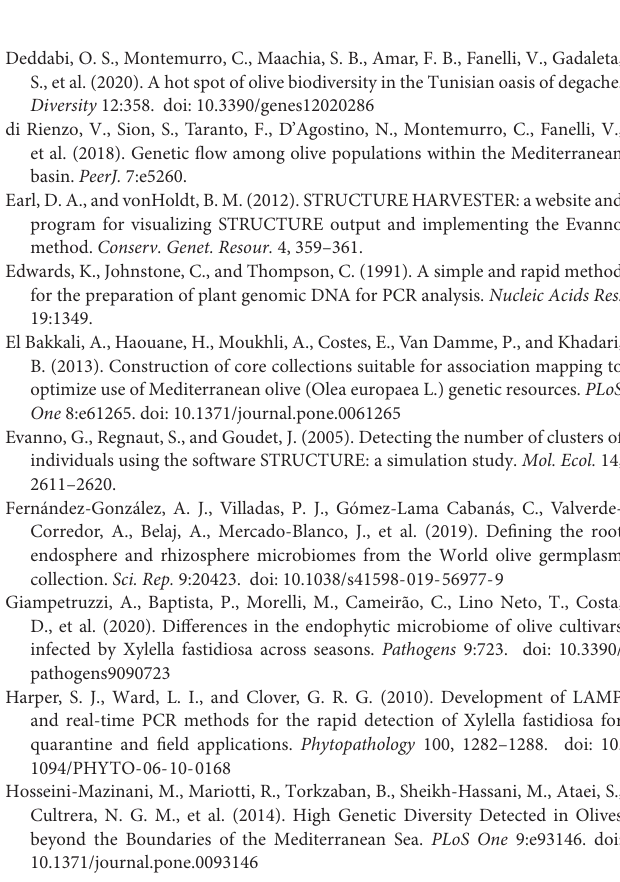
Supplementary Figure 1 | Distribution of (A) disease severity scores (S) and (B) bacterial concentration (C) in thirty putatively resistant plants (PRPs) and respective control plants (CPs). Supplementary Figure 2 | Parametric study of genetic structure. (A) Distribution of the (cid:49) K parameter. (B) Genetic structure for three subpopulations ( K = 3). Each individual is represented by a vertical line, which is partitioned into colored segments whose length is proportional to the estimated membership fraction (qi) in each subpopulation. Supplementary Figure 3 | Bacterial colonization levels in PRPs included in K1 with respect to control plants. Supplementary Table 1 | Features of the SSR loci used in this study, including the repeat motif, forward and reverse sequences, and reference in scientific literature. Supplementary Table 2 | Summary statistics for the SSR analysis. For each SSR locus, the number of alleles, allele sizes, and polymorphic information content (PIC), are indicated. Supplementary Table 3 | Membership coefficients (q i ) of the individuals genotyped in this study for the three subpopulations identified by STRUCTURE analysis. Individuals grouped in the clusters K1 and K2 identified by hierarchical clustering are